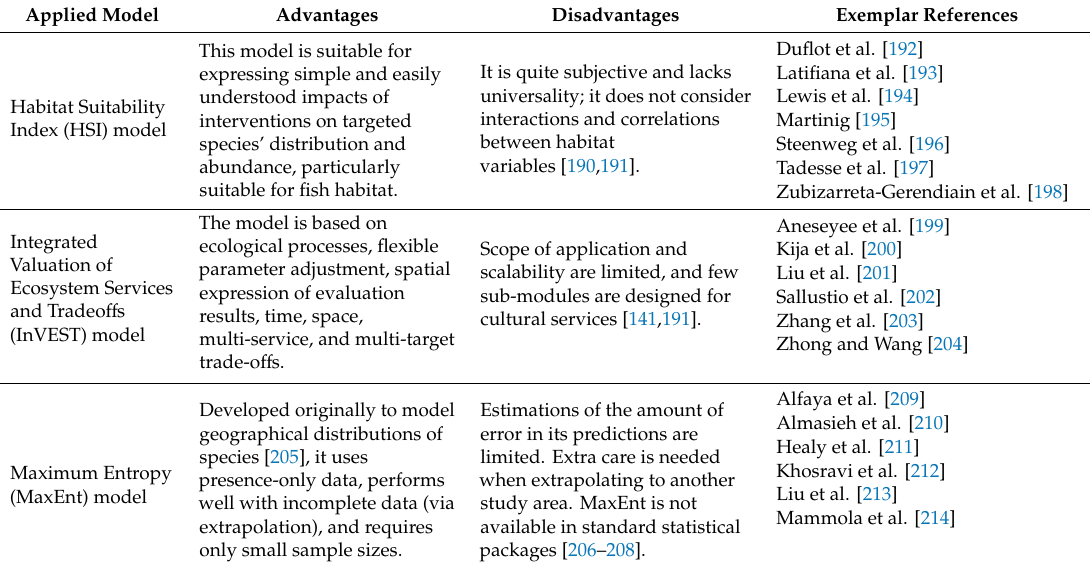
Table 3. Habitat quality assessment